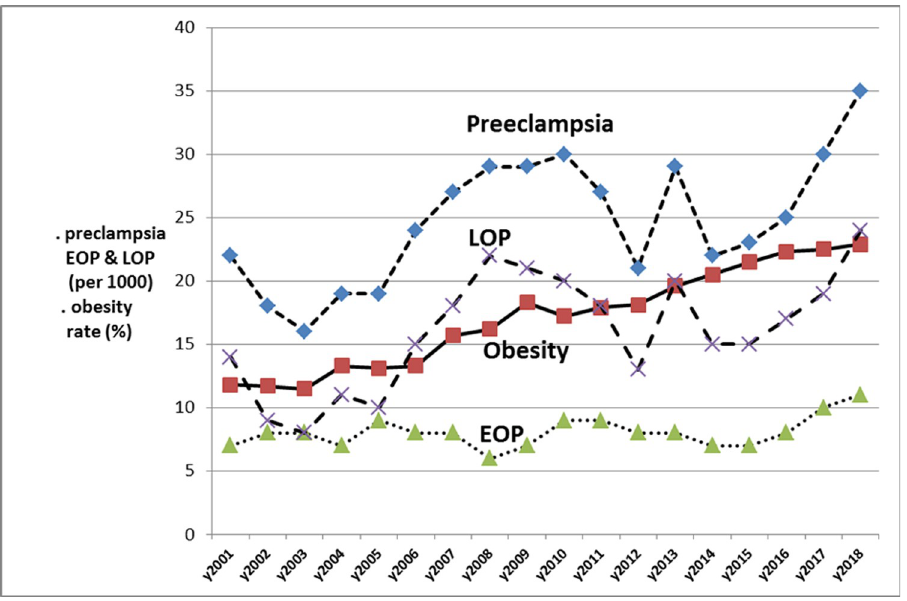
Fig 3. Evolution per year 2001–2018 in South-Re´union of the incidence of obesity (in per cents), and the incidence of preeclampsia, early onset preeclampsia and late onset preeclampsia (per 1000).